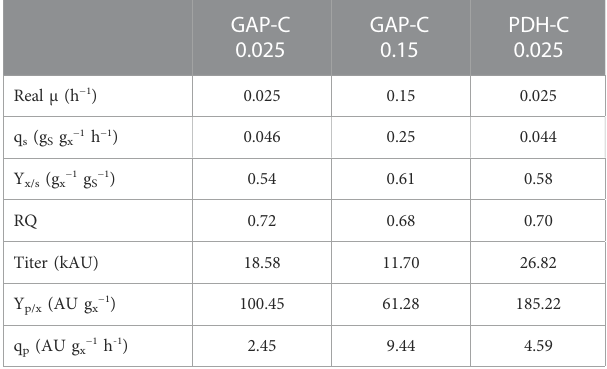
TABLE 1 Physiological and product-related parameters from carbon-limiting fed-batch cultivations with PDH-C at low µ (0.025 h -1 ) and GAP-C at high (0.15 h -1 ) and low µ (0.025 h -1 ). All parameters are calculated from the feeding